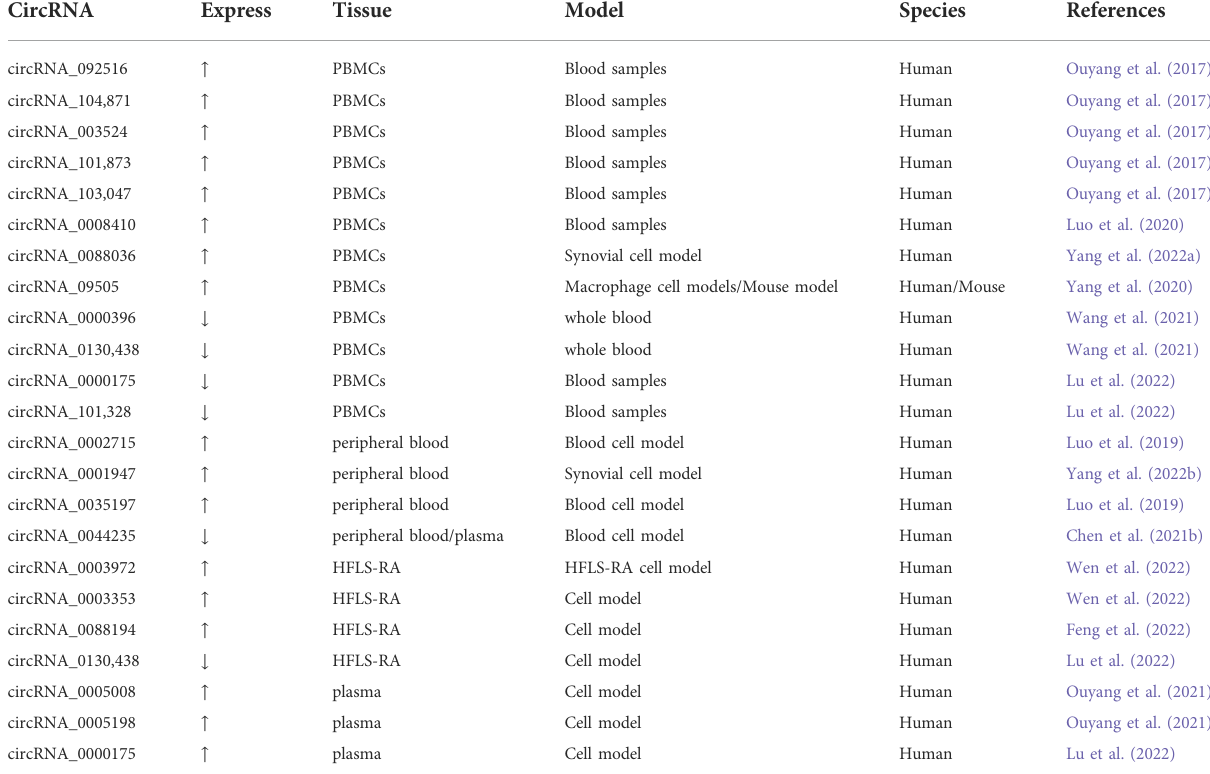
TABLE 1 The aberrantly expressed circRNAs in